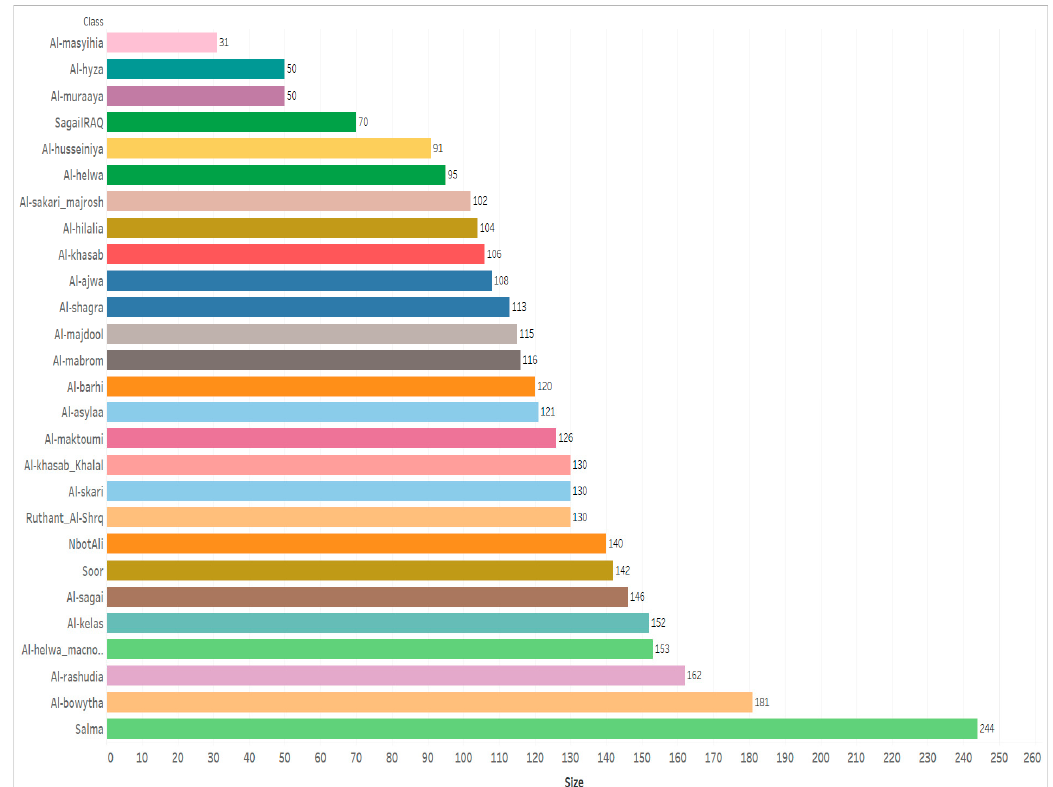
Figure 30. Plotting diagram for date fruit distribution of classes.